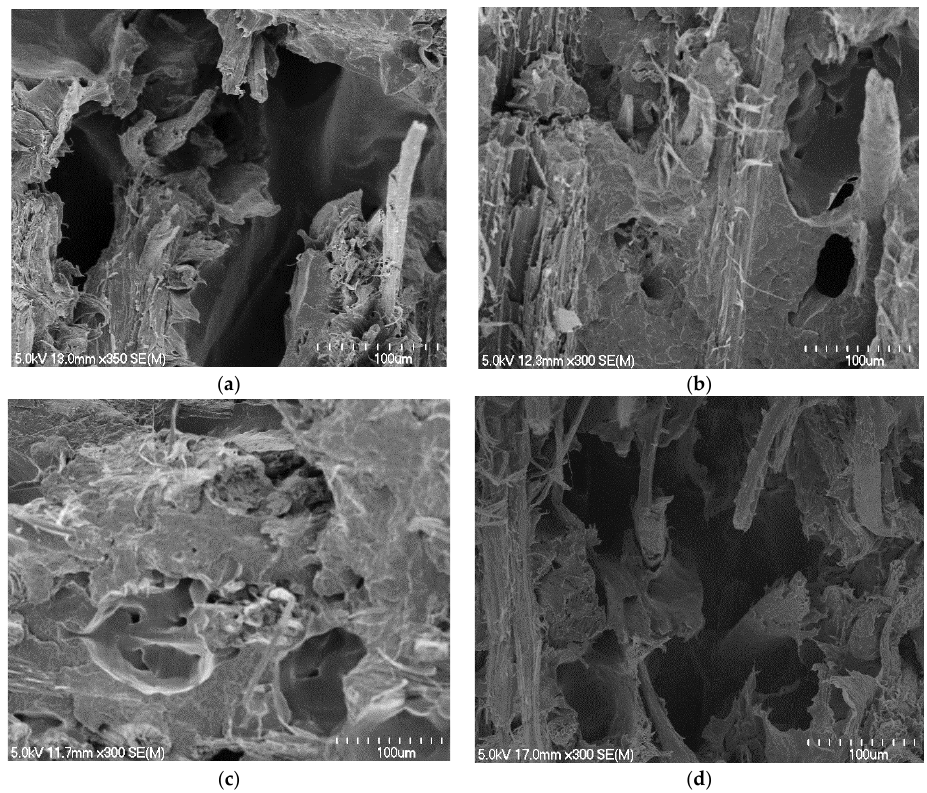
Figure 9. Scanning electron micrographs of tensile fracture surfaces of composites containing fibre content of ( a ) 45 wt% made with polymer sheets of 0.56 mm, ( b , c , d ) 50, 60, and 70 wt% made with polymer sheets of sheet thickness of 0.29 mm, respectively.